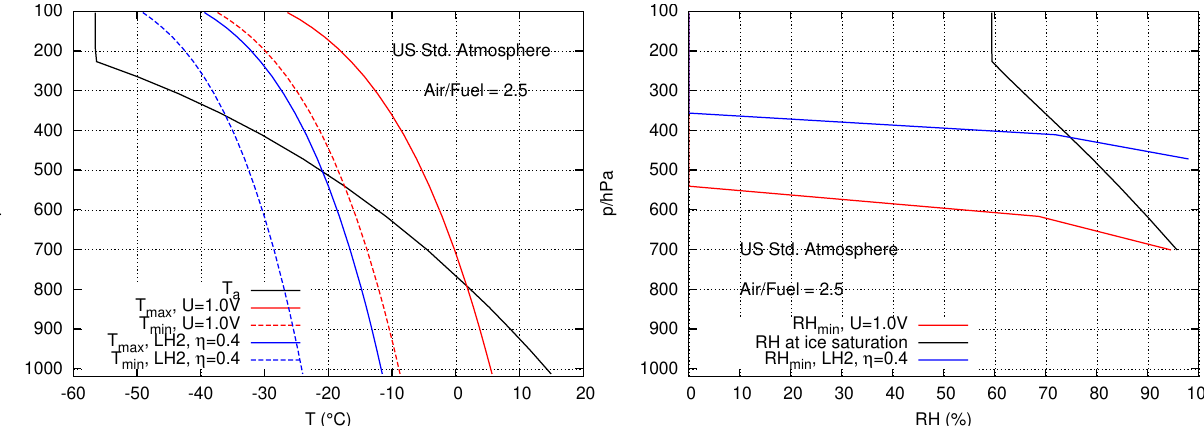
Figure 4. Comparison of contrail formation conditions for fuel cells (red) and combustion of liquid hydrogen (LH2) in a gas turbine (blue). The left panel shows the temperature conditions and the right one the conditions on relative humidity as in Figures 2 and 3